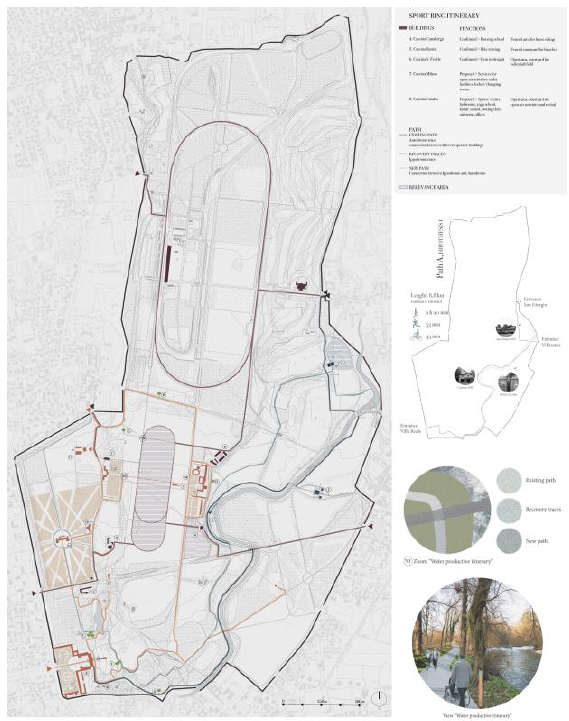
Figure 7. Royal Park of Monza Itinerary map proposal: a sport ring pedestrian and bicycle itinerary, that connects several buildings currently existing in the park and makes readable traces from the past, documented by Giovanni Brenna’s map. The trails are built in calcestre (stabilized gravel), in three different shades of grey to differentiate existing (racetrack), recovery (old hippodrome) and new